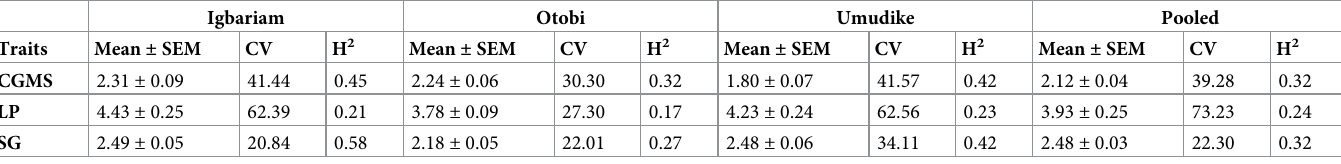
CGMS, cassava green mite severity; LP, leaf pubescence; SG, stay